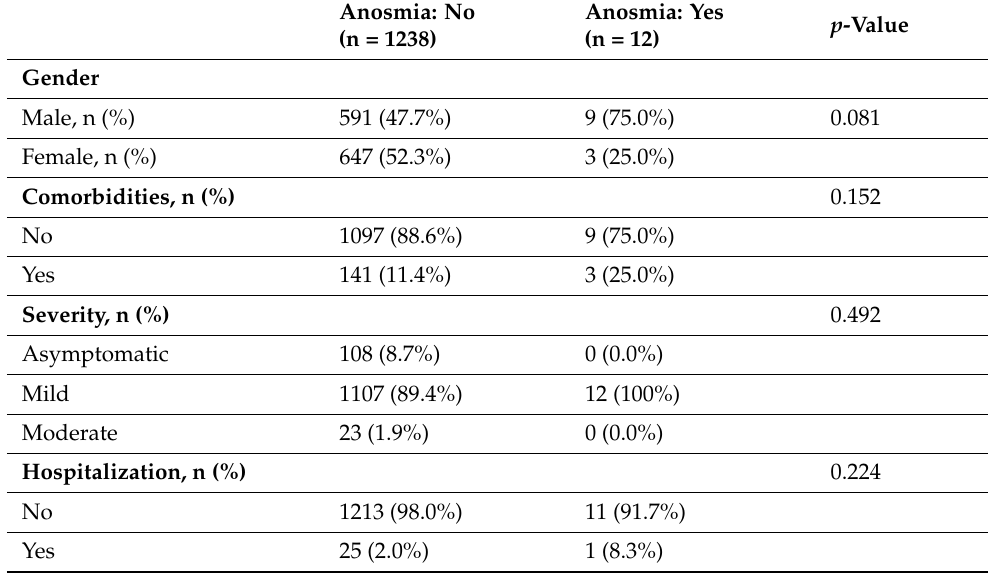
Table 3. Anosmia at FUP